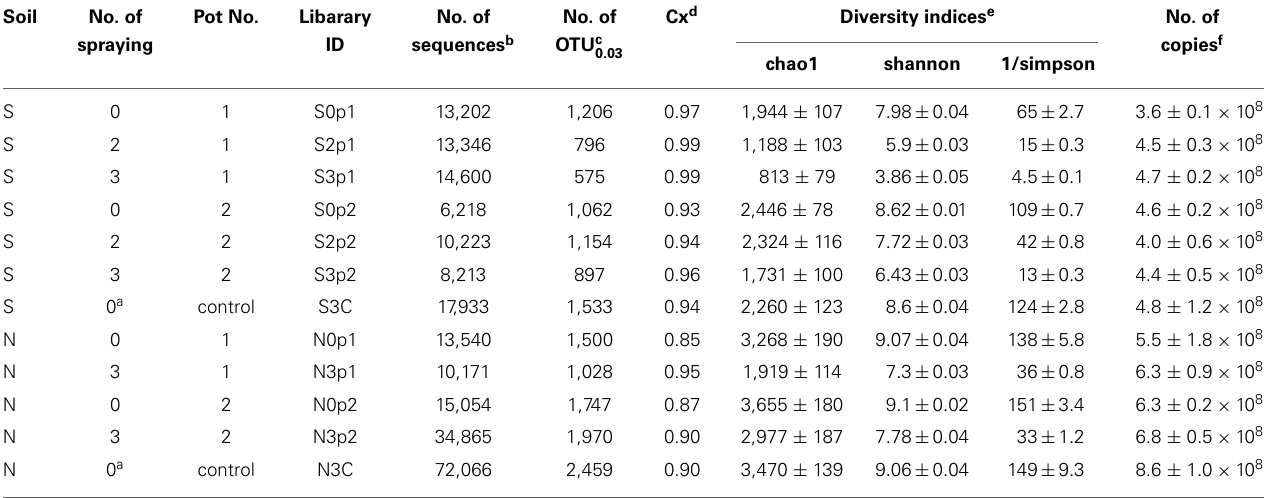
Table 1 | Summary of deep sequencing and qPCR. Soil No. of Pot No.